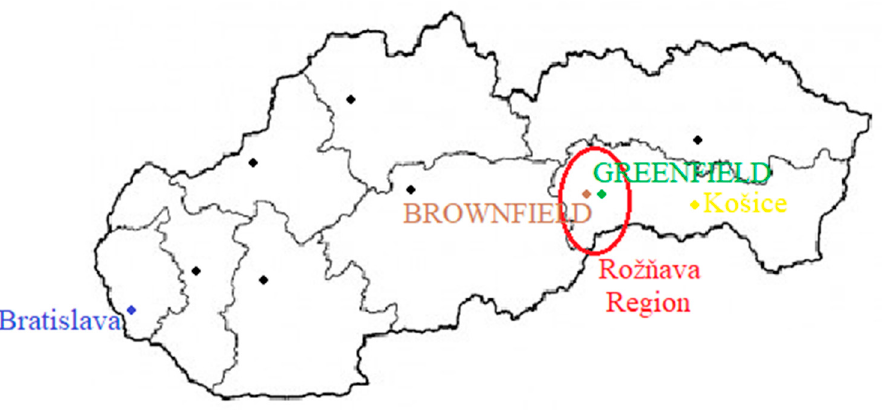
Figure 3. An indicative map of the location of brownfield and greenfield investment projects.